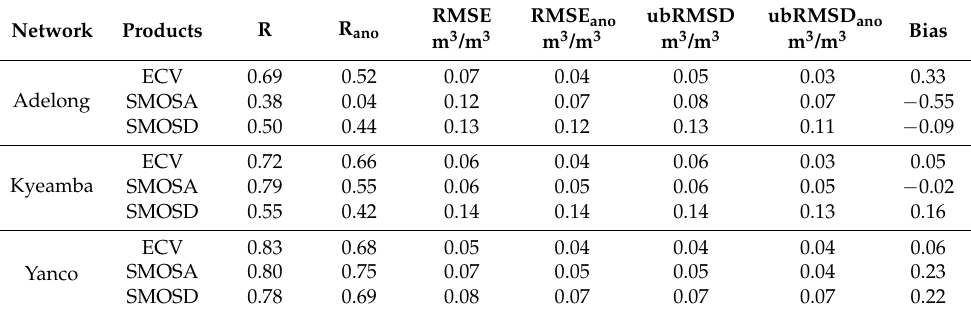
Table 3. Error metrics for the network scale of different products.